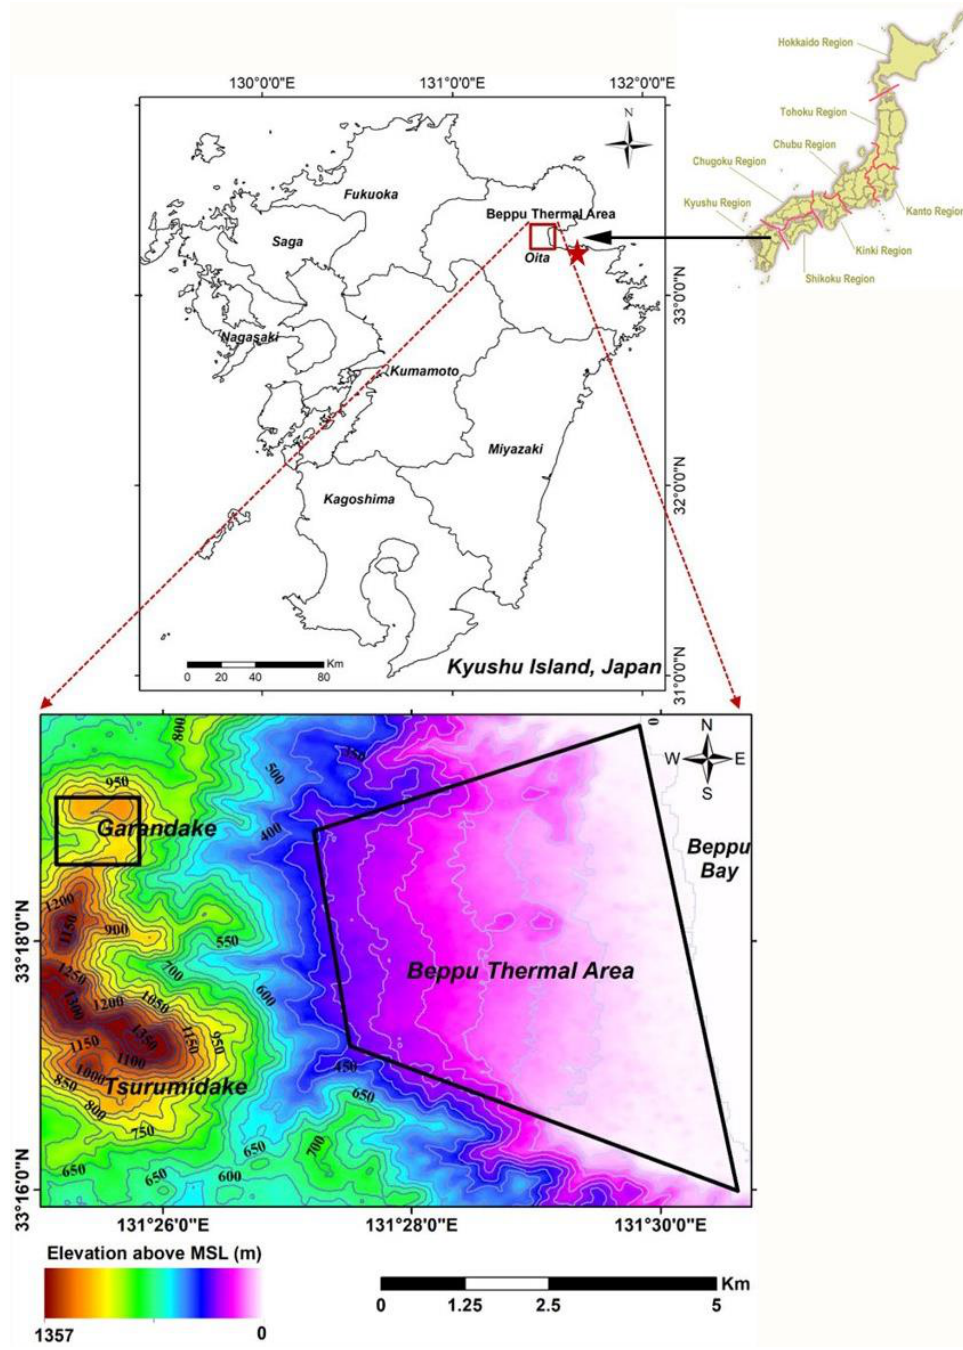
Figure 1. Location map of the study. The Beppu geothermal area is shown using a polygon and Mt. Garan fumaroles are shown with a square. Contours show elevation in meters above mean sea level, prepared using the values of shuttle radar topography mission digital elevation model. The Beppu geothermal area is about 22 km 2 and Mt. Garan fumaroles are about 0.7 km 2 . The Oita meteorological station (Automated Meteorological Data Acquisition System, AMeDAS) is shown with a star in the index map of Kyushu Island, located at 33°14.1′ N and 131°37.1′ E.